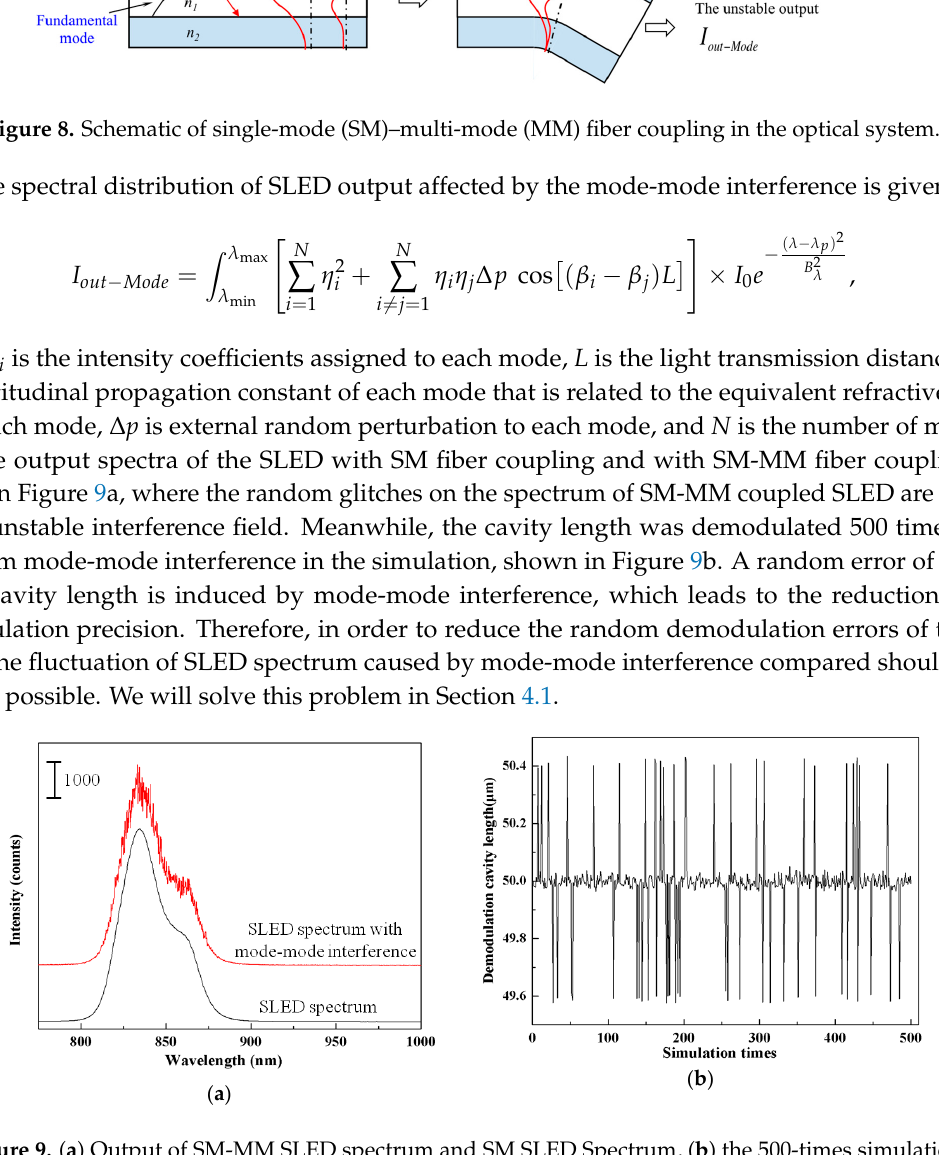
Figure 10. Schematic of a fiber phase modulator based on the piezoelectric ceramic transducer. According to a number of experiments, a rectangular wave voltage with the frequency of 29 kHz was applied to the piezoelectric ceramic transducer (PZT). The experimental output spectrum was shown in Figure 11, with PZT driven voltage of 0 V, 40 V, and 80 V, respectively. The SLED spectrum with Gaussian distribution became more stable with the increase of the driven voltage.